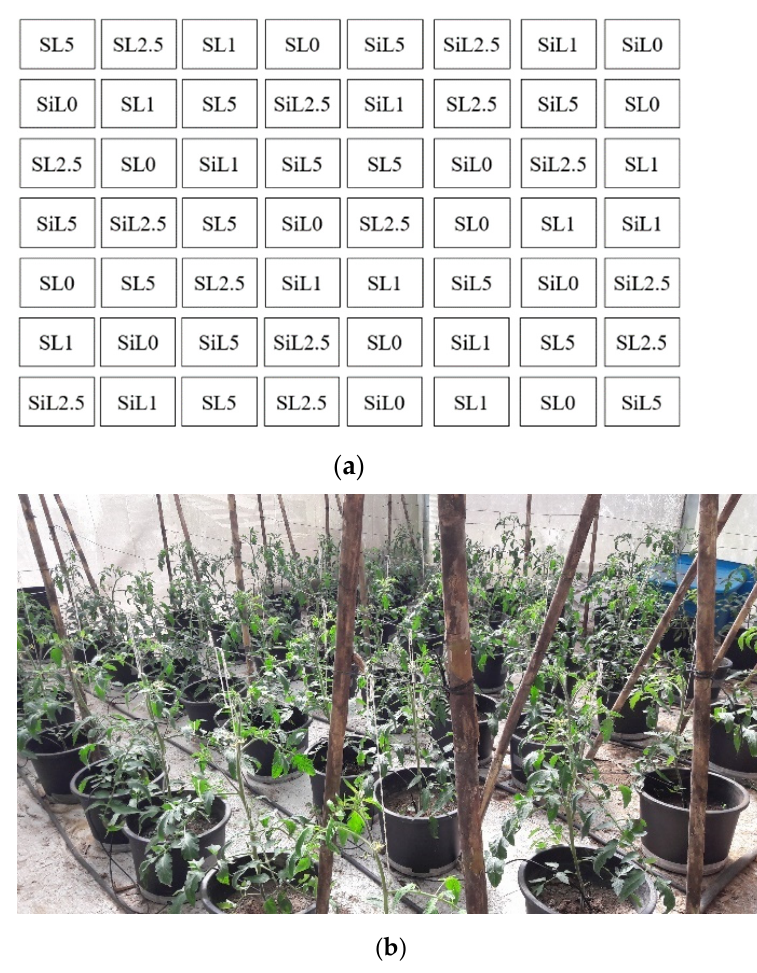
Figure 2. Experimental setup of pots in the greenhouse: ( a ) Scheme of the random block design of each pot replicate where SL refers to sandy loam soil, SiL refers to silt loam soil and numbers 0, 1, 2.5, and 5 refer the application rates (%-dry weight) of bamboo biochar; ( b ) pots in position and their irrigation system.